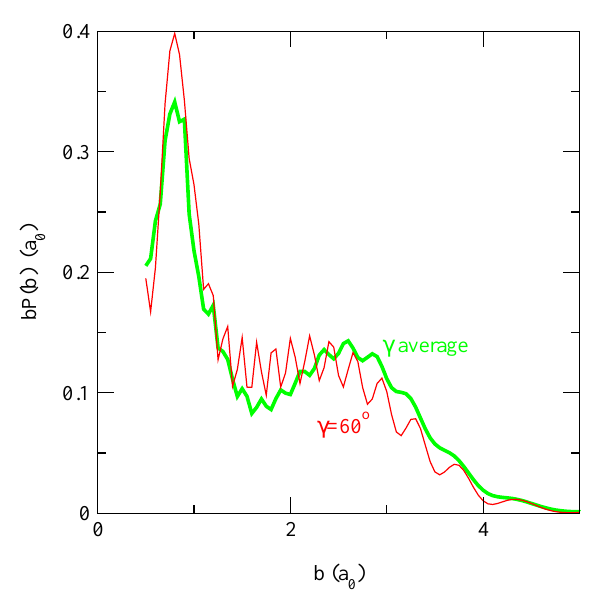
Figure 5: Comparison between the charge transfer transition probabilities averaged over γ figure 4, panel (f), (grey thick line) with a single isotopic result at γ 62 . 5